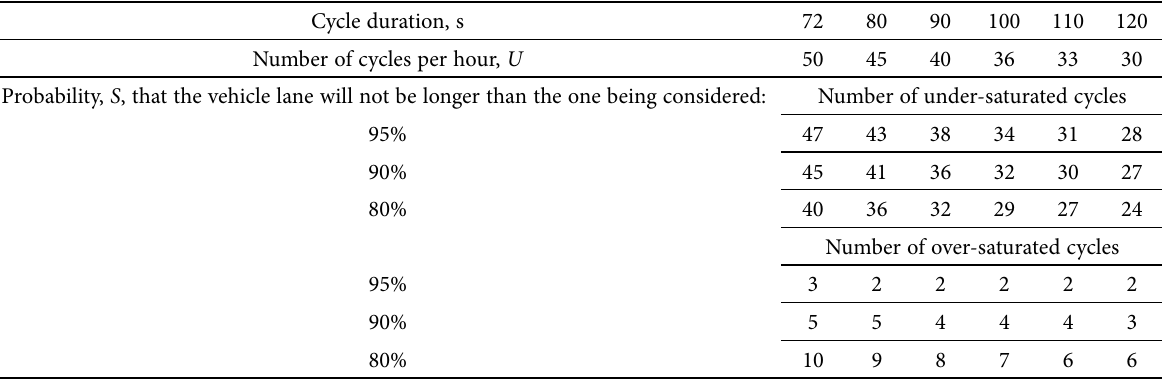
Table 3. Number of saturated and unsaturated cycles per hour under different duration of cycle Cycle duration,